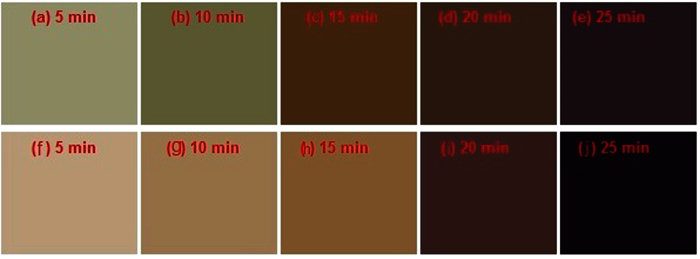
Photographs of MAxFA1−xPbI3 films with (a–e) 10 and (f–j) 400 sccm H2 flow rates with growth time increasing from 5 to 25 min.